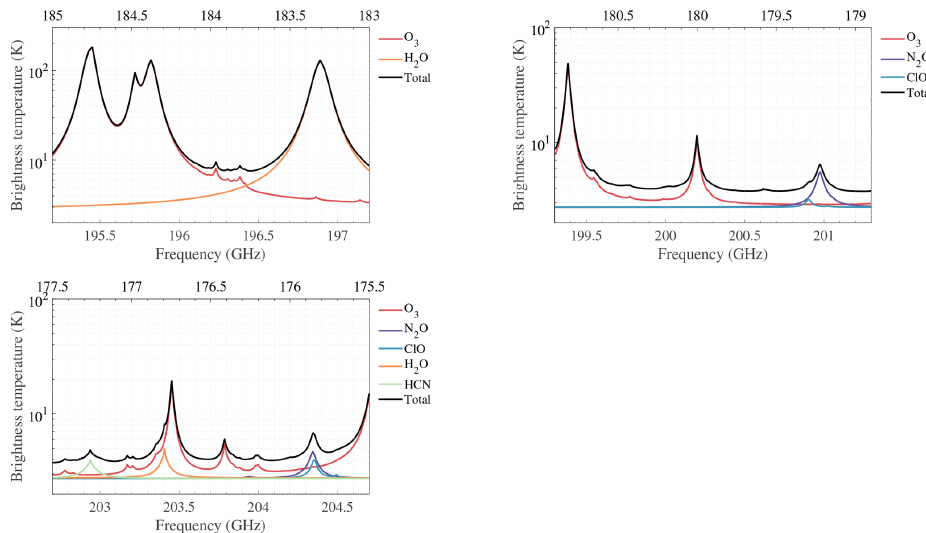
Figure 5. Contributions of the main target chemical species to the 190GHz spectra. The brightness temperature is measured from the double- sideband radiometer. The tangent height is 30km. The top axis represents the lower sideband frequencies and the bottom axis represents the upper sideband frequencies. Each panel represents a single spectrometer.